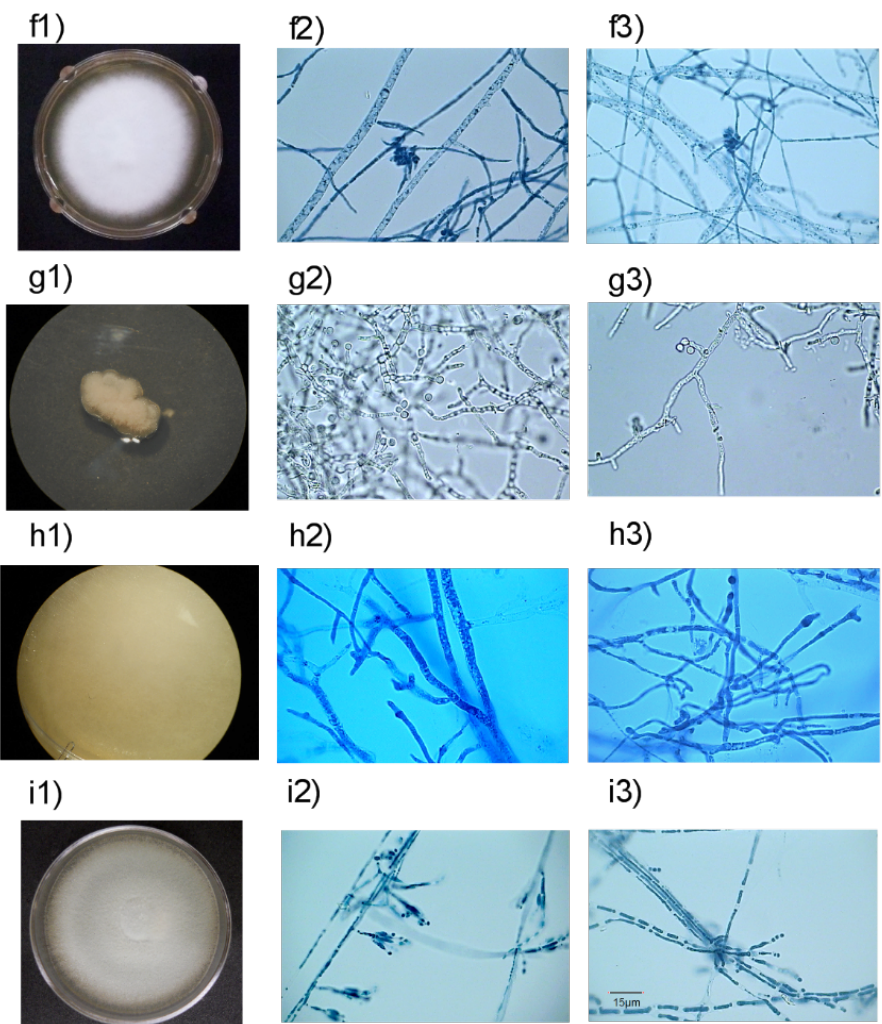
Figure 4: Fungal isolates from marine sediments showing colony morphology, hyphae and reproductive structures stained with and without lactophenol cotton blue using light microscopy, 1000X: f1) - f3) Chaetomium sp; g1) - g3) Phialosimplex sp; h1) - h3) Epicoccum sp; i1) - i3) Talaromyces